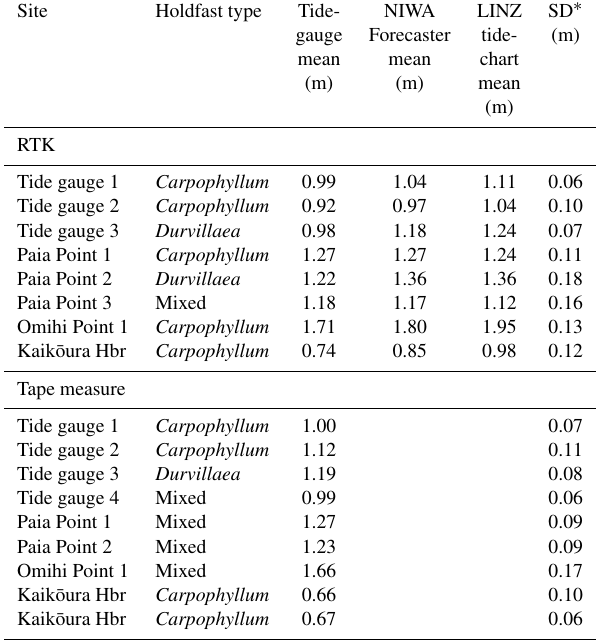
Table 5. Comparison of mean uplift values derived using RTK for the various methodologies (e.g. tide-gauge calibration method, NIWA Forecaster method, LINZ tide-chart method). As the source data remain identical for each method, the standard deviation re- flects error derived from the RTK measurements. Data are presented by site at each location; when a site was sampled using both Car- pophyllum and Durvillaea , the holdfast type is recorded as